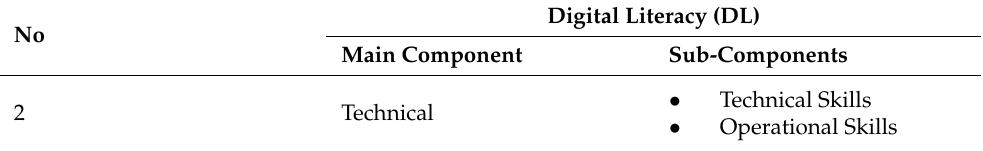
Table 2. Technical Sub-components.